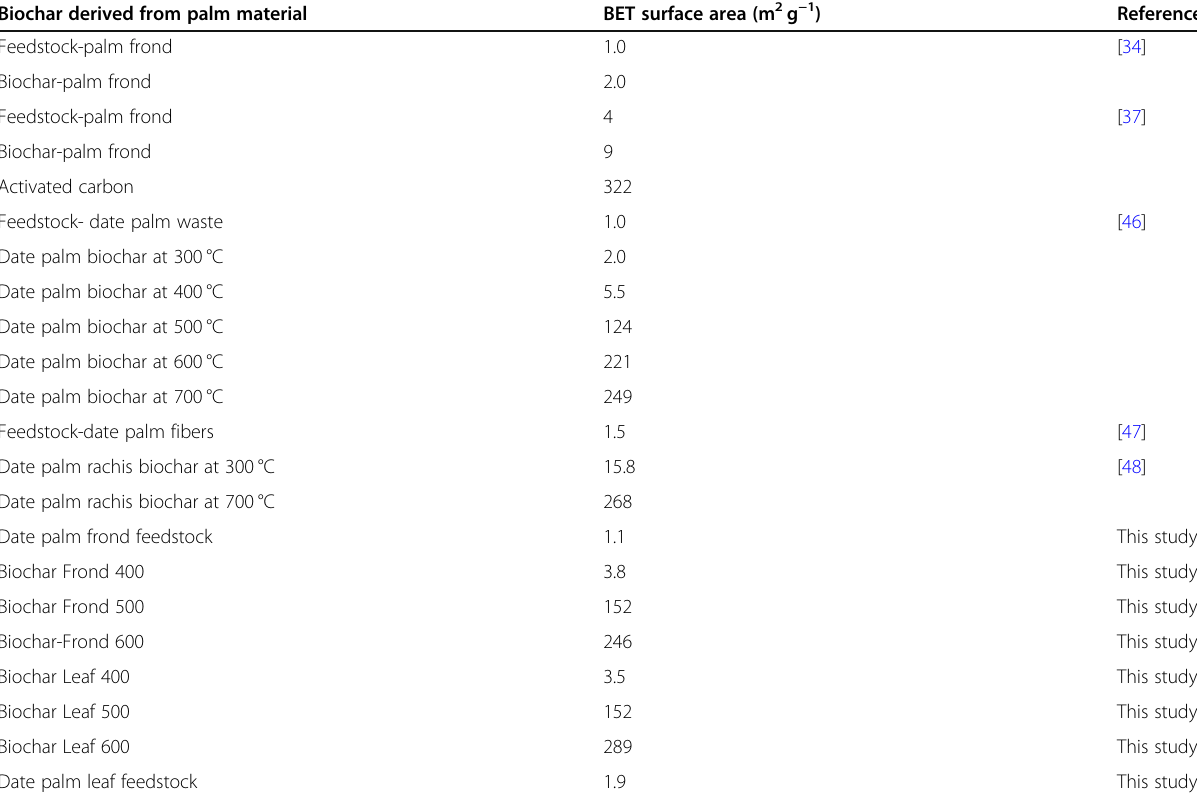
Table 3 BET analysis results and comparison with biochar derived from palm material Biochar derived from palm